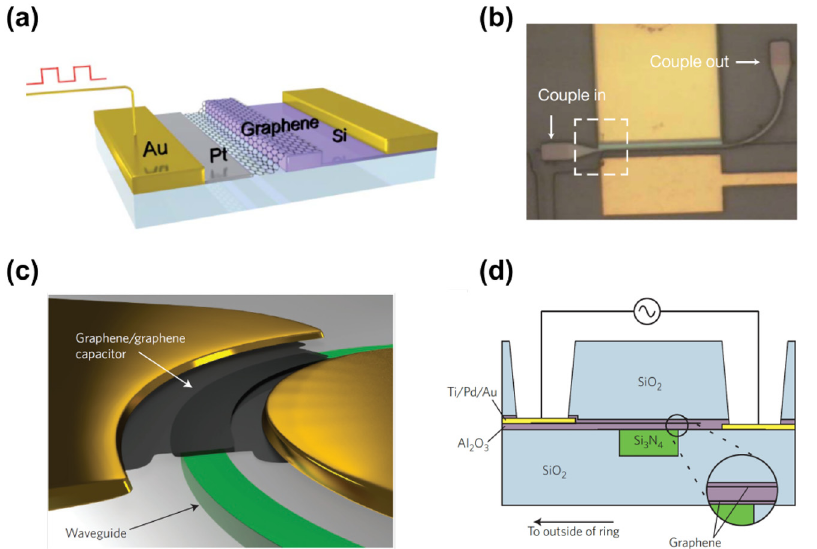
Figure 4: Graphene based devices. (a) A graphene-based waveguide-integrated optical modulator. (b) Top-view optical mi- croscope image of the waveguide ((a) and (b) are reproduced from [68]). (c) Schematic of the modulator consisting of a graphene/ graphene capacitor integrated along a ring resonator. (d) Cross-section of the device. Two layers of graphene separated by 65 nm interlayer Al 2 O 3 dielectric form a parallel- plate capacitor. ((c) and (d) are reproduced from